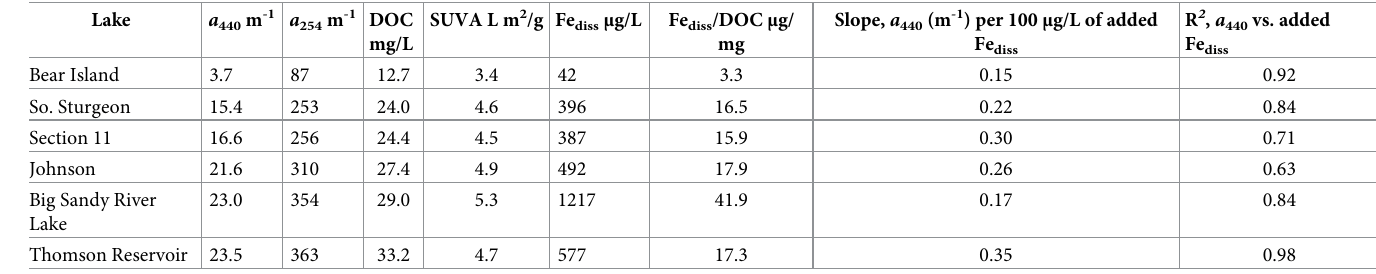
Table 4. Chemical characteristics of lakes and results for iron addition experiment.